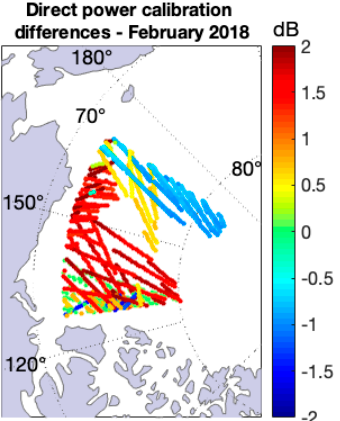
Figure 15. Impact of the direct signal power and gain differences between GPS satellites for February 2018 data. Up to 4 dB total difference correction is observed from minimum to maximum values, which applies to both H-pol and V-pol.